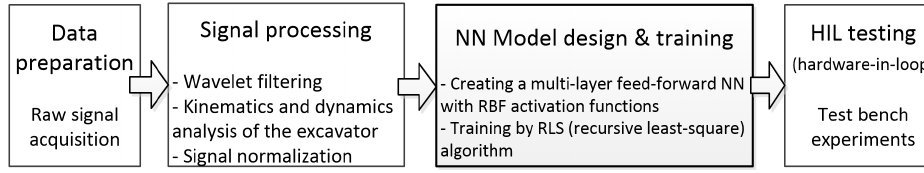
Figure 6. Flowchart of a hydraulic excavator load prediction process by [9].